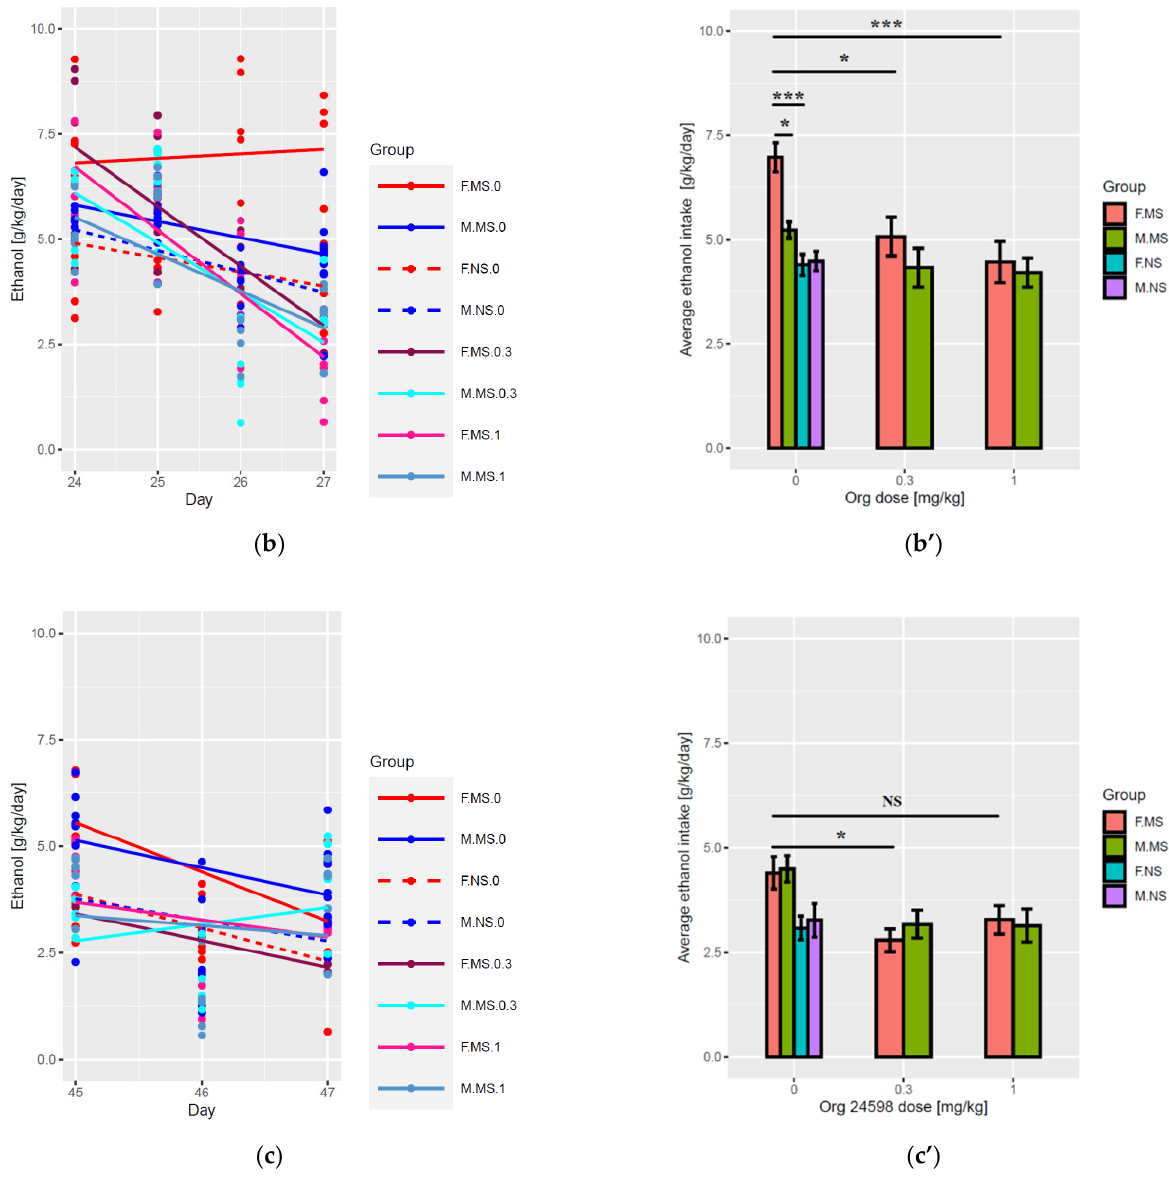
Figure 1. Effect of Org 24598 on ethanol (6% v / v ) intake in two-bottle choice paradigm in male and female Wistar rats ( n = 8) subjected to MS for 180 min during PND1-21. ( a , a’ ) Effect of MS on baseline ethanol intake during 12–14th days of drinking procedure (PND40-42); ( b , b’ ) Effect of Org 24598 (0.3 mg/kg and 1.0 mg/kg) or vehicle treatment on ethanol intake during 24–27th days of drinking procedure (PND52-55) after 1 week of ethanol deprivation; ( c , c’ ) Effect of Org 24598 (0.3 mg/kg and 1.0 mg/kg) treatment or vehicle on ethanol intake during over days 45–47th drinking procedure (PND73-75) after the following 2 weeks of ethanol deprivation; Left and right panels show the same results, in linear and bar plots. For statistics, see the Results section. PND—postnatal day; MS— maternal separation; NS—non-separated; F—female; M—male; 0—vehicle; 0.3—Org 24598 at the dose of 0.3 mg/kg; 1—Org 24598 at the dose of 1.0 mg/kg. The bar plots show the average ethanol intake over three days of ethanol drinking. * p < 0.05; *** p < 0.001 vs non-separated; NS—nonsignif- icant.